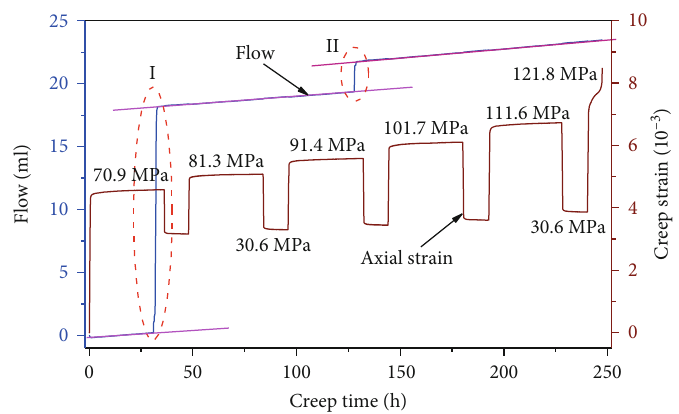
Figure 7: Creep strain and rate versus time under σ and rate versus time.